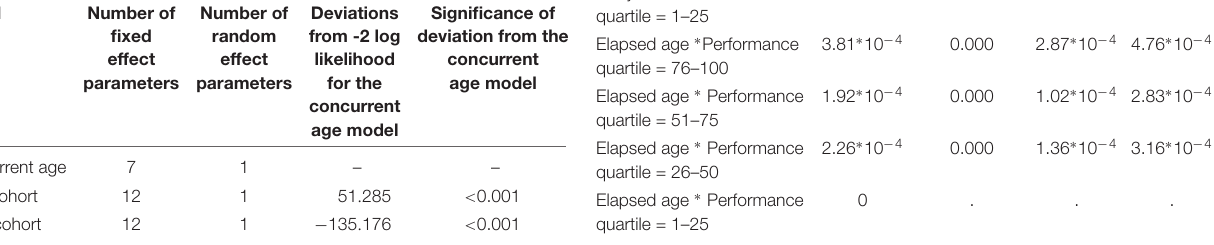
TABLE 2 | Goodness of fit of the birth cohort and entry cohort models compared to the concurrent age model. Model